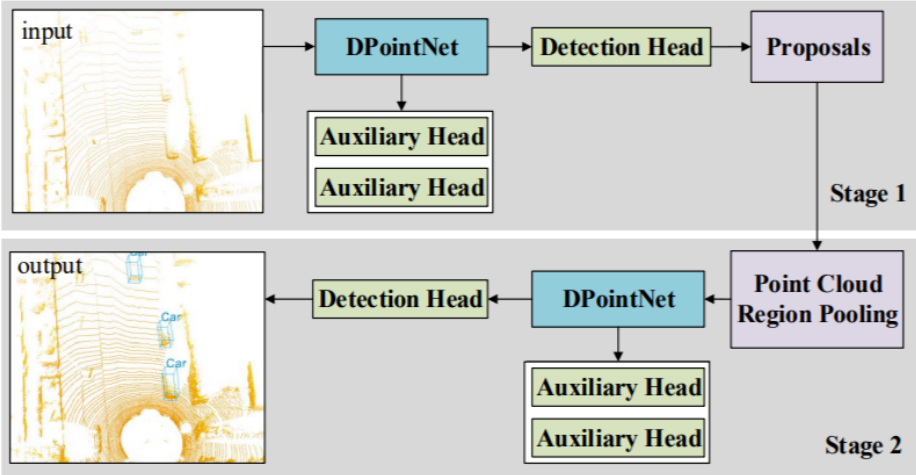
Figure 17. The architecture with DPointNet [68] detector consisting of two stages for 3D proposal generation and proposal